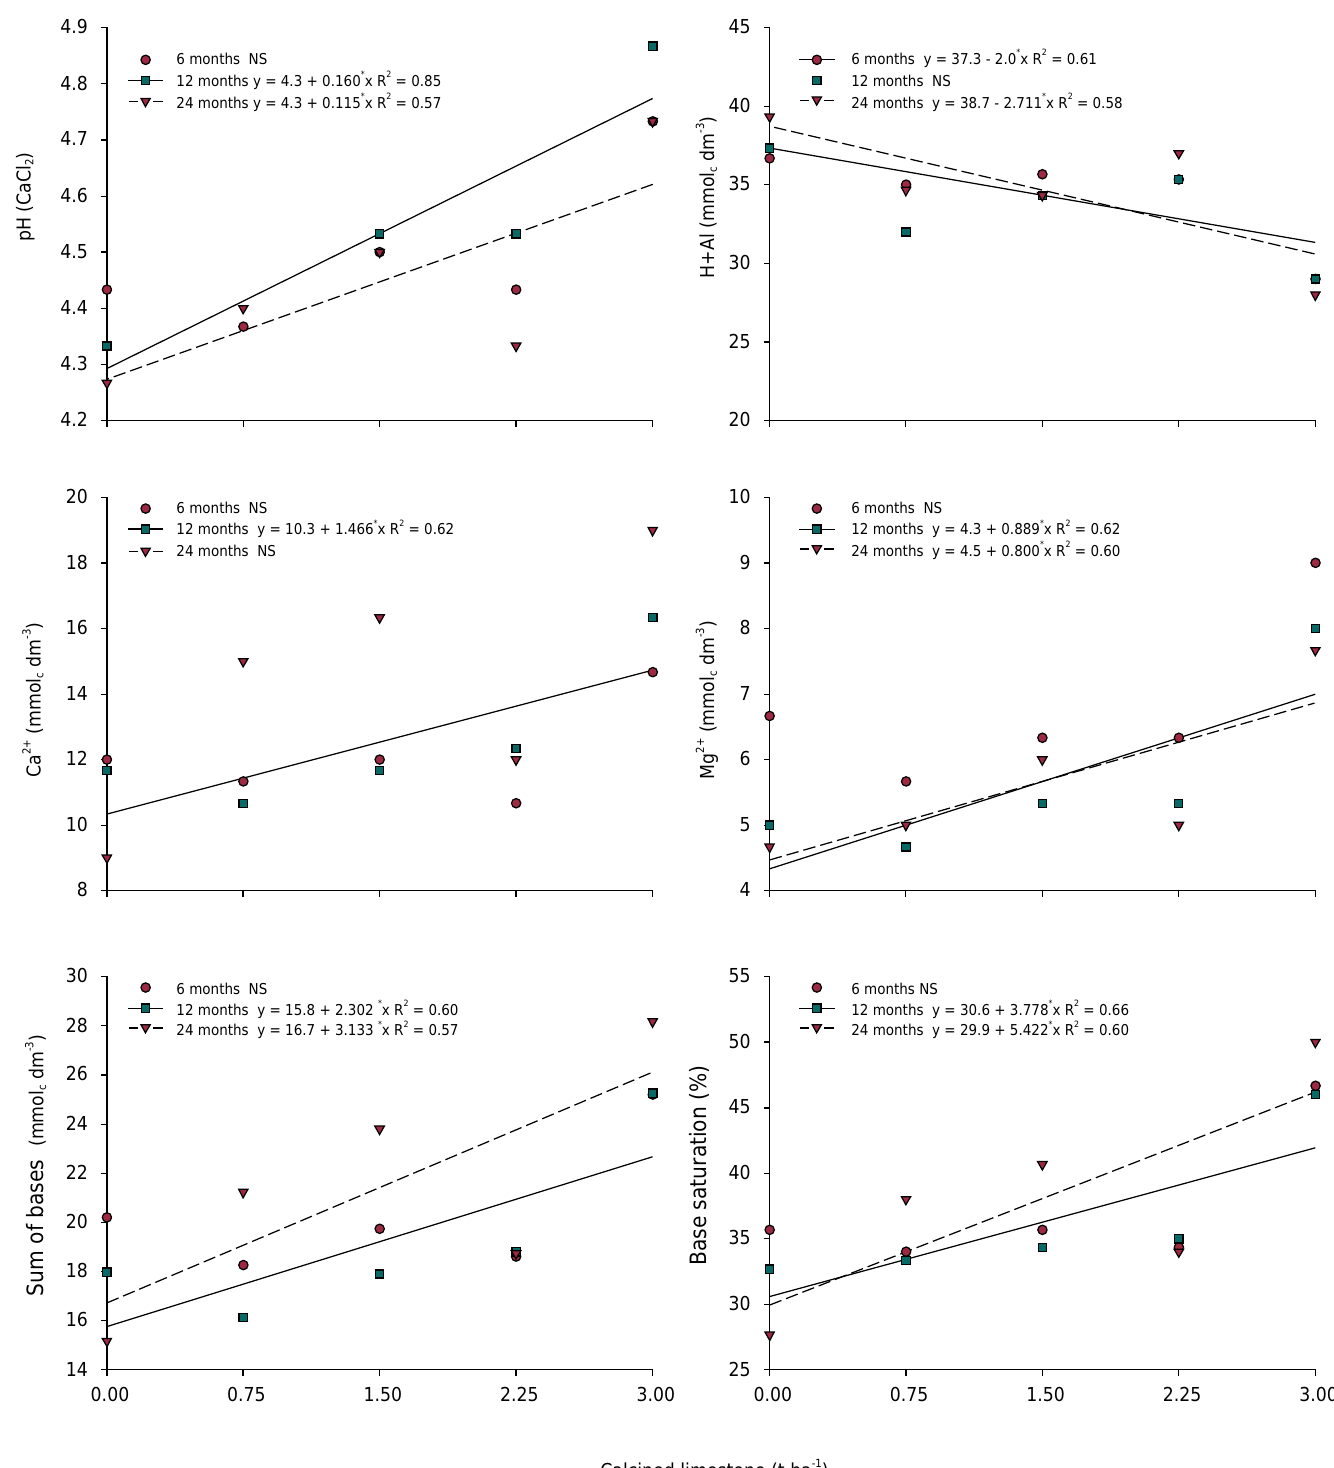
Figure 4. The pH value, potential acidity, Ca 2+ , Mg 2+ , sum of bases, and base saturation in the 0.10-0.20 m layer of an Argissolo Vermelho Amarelo [Ultisols (Soil Survey Staff, 2014)] in response to the rates of calcined limestone applied, without incorporation. The dots represent the averages of three replicates. ** and * indicate significance at 1 and 5 % probability,